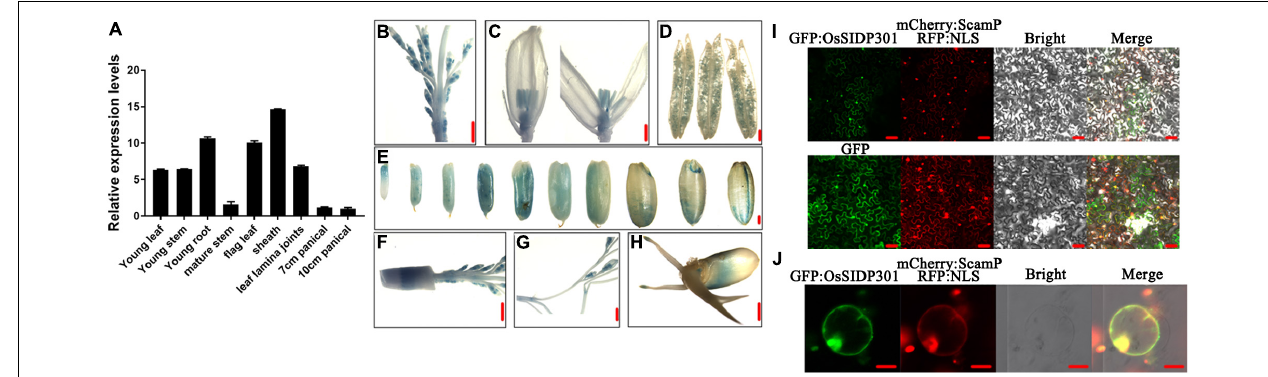
FIGURE 1 | Expression profiling and subcellular localization. (A) Transcript levels of OsSIDP301 in various tissues. OsACTIN1 was used normalized and data are shown as mean ± SD ( n = 3). Promoter–GUS activity of OsSIDP301 in young panicle (B,F,G) , pollen (D) , stigma (C) , seed maturation stage, (E) and germination stage (H) , bar = 1 mm (B,C,E–H) , bar = 10 µ m (D) . Subcellular localization of OsSIDP301-GFP in N. benthamiana leaves (I) , bar = 50 µ m and rice protoplast (J) , bar = 20 µ